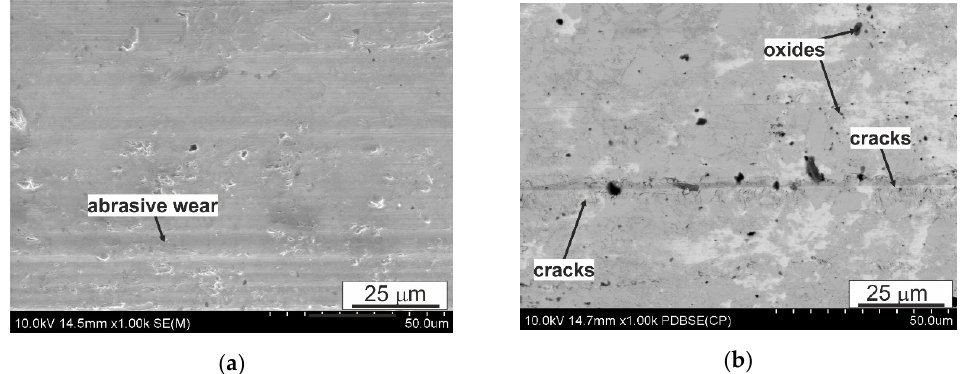
Figure 12. Characteristic sample surface of B89 alloy after tribological tests in lubricated friction, ( a ) 10,000 m; ( b ) start-stop 10 × 1000 m, SEM.